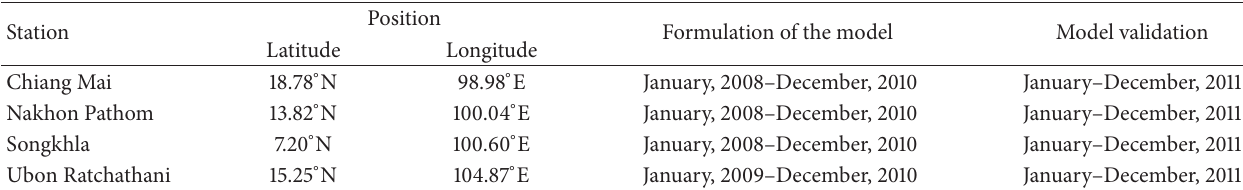
Table 1: Schedule of data for the formulation of the model and model validation. Station